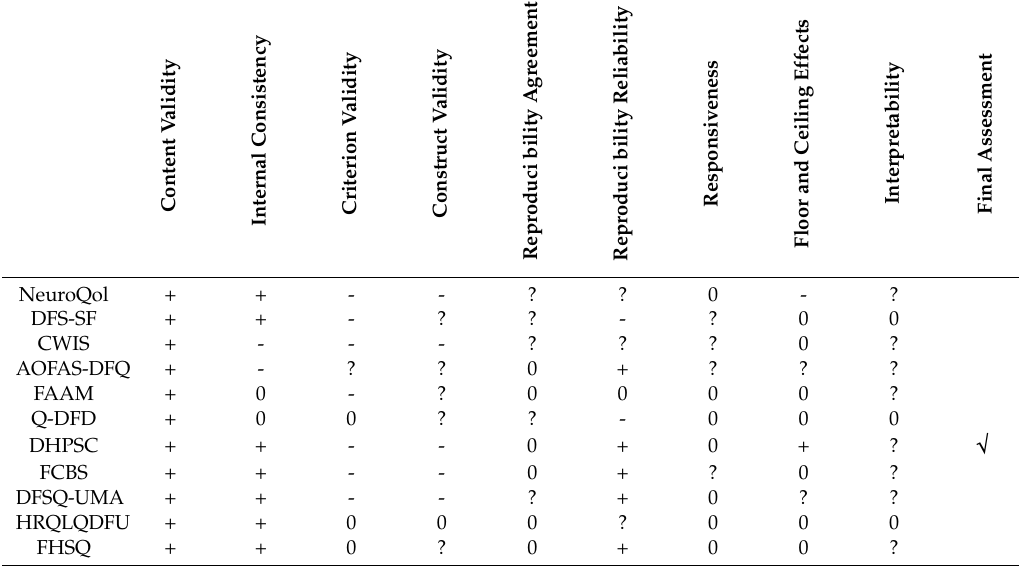
Table 3. Summary of the assessment of the measurement properties of all questionnaires.